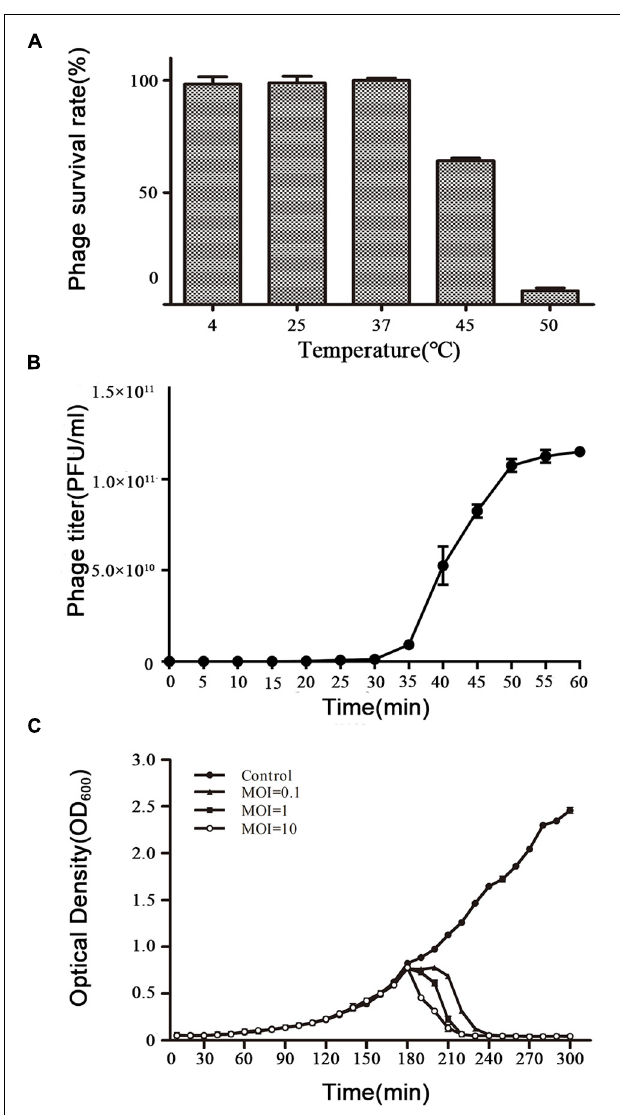
FIGURE 2 | Biological characteristics of phage vB_ShiP-A7. (A) The survival rate of vB_ShiP-A7 after treatment at different temperatures for 1 h. (B) One-step growth curve of vB_ShiP-A7 on strain Shiglla flexneri A7 at 37 ◦ C. (C) Bacterial challenge assay with phage vB_ShiP-A7 to Shiglla flexneri A7. vB_ShiP-A7 was added at MOIs of 0.1 (close triangles), 1 (close squares), and 10 (open circles) to different bacterial cultures after 2 h incubation (OD600 = 0.25). SM buffer instead of vB_ShiP-A7 was inoculated into a bacterial culture and used as the negative control (close circles). The light absorption value at OD600nm of each bacterial culture was recorded at 15 min intervals over a period of 300 min. In (B,C) , data from 3 independent experiments are combined and presented as the mean with the Standard Error of Mean